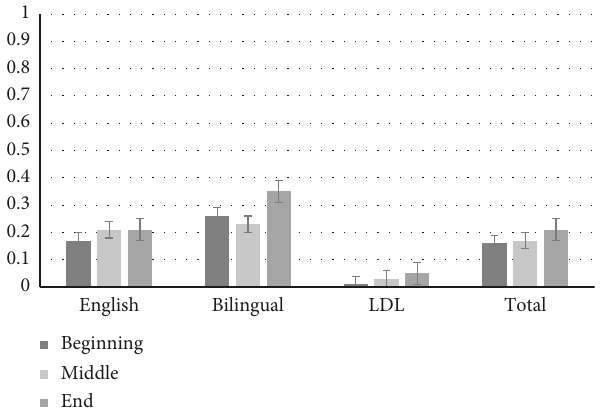
Figure 3: Means and standard errors for WER III (perfect word string: 3+ consecutive words within a T-unit not deemed perfect or flawed) at the beginning, middle, and end of the year by language